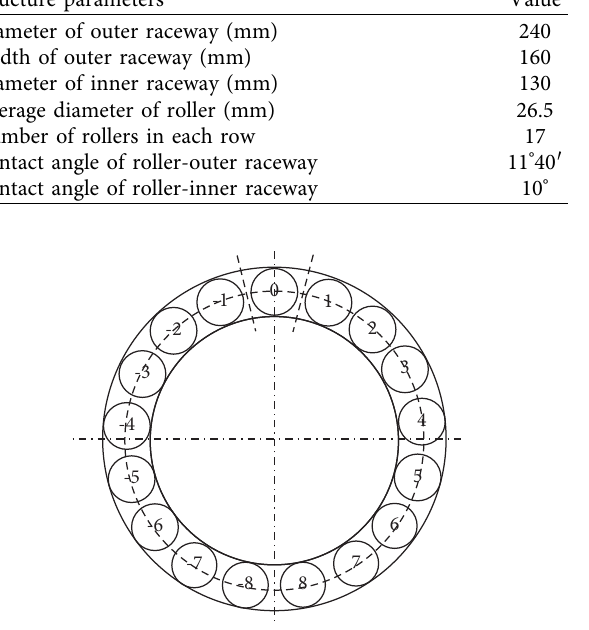
Figure 7: Outer raceway zone division.